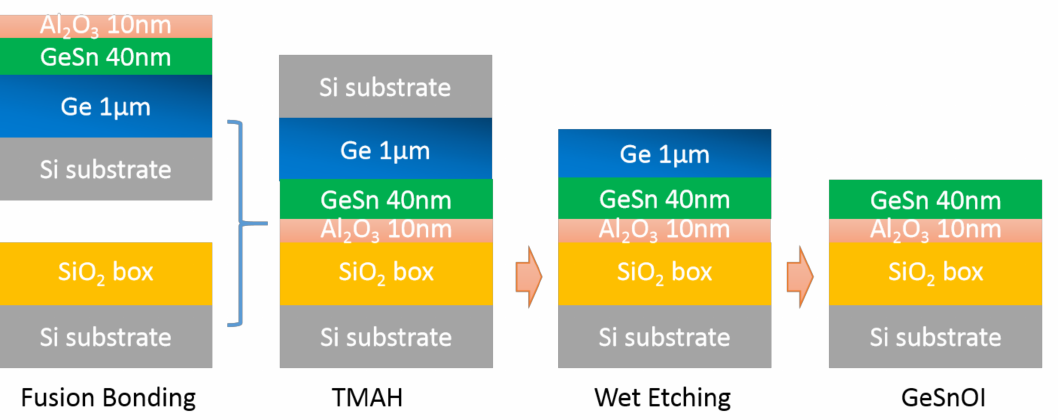
Figure 2. Process flow for manufacturing of GeSnOI